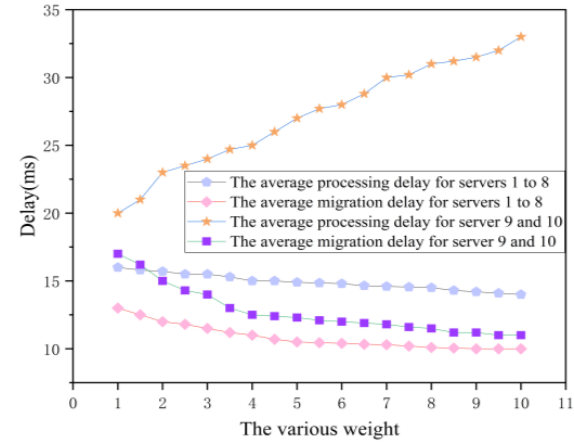
Figure 10. The impact on delay for servers 1 to 10.